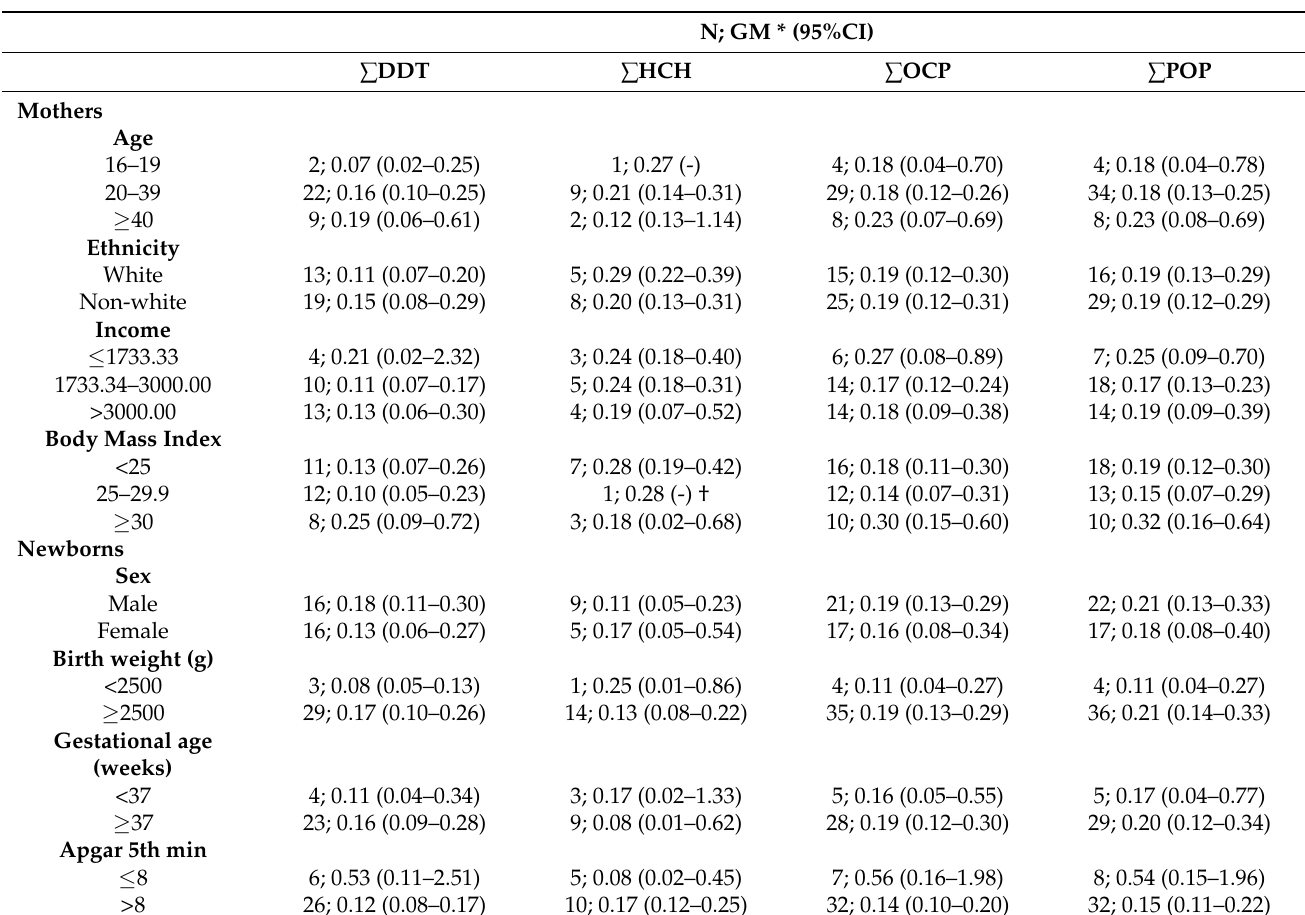
Table 3. Levels of OCPs and PCBs according to maternal sociodemographic characteristics and birth variables. Rio Birth Cohort pilot study. Rio de Janeiro, Brazil, September 2017 to February